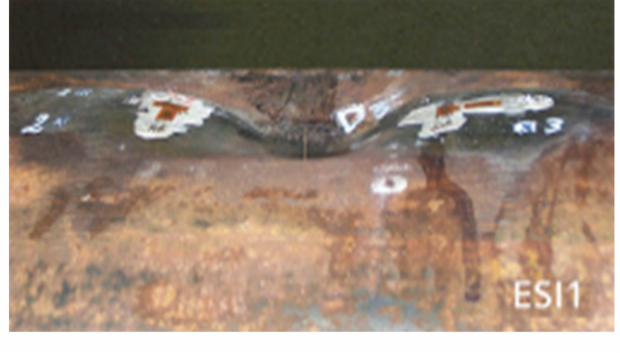
Figure 20. General aspect of a plain dent in a